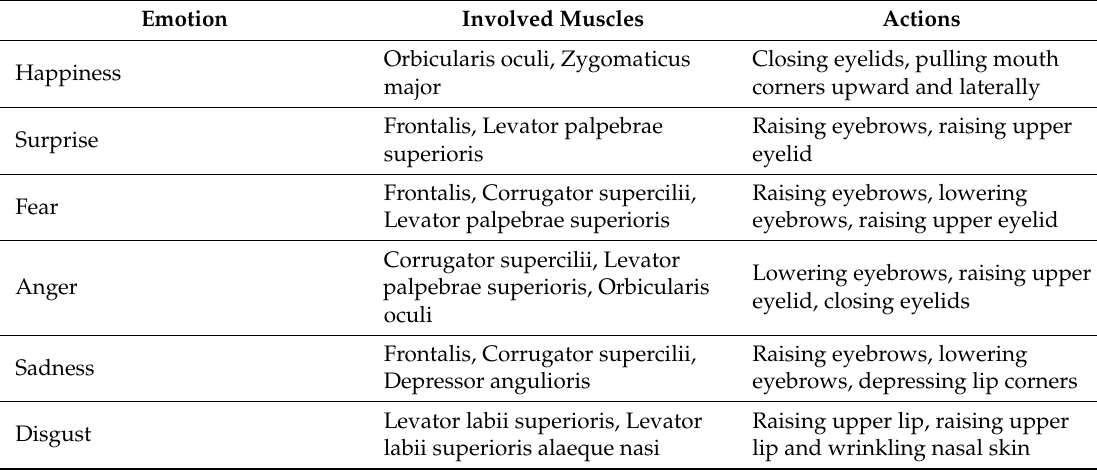
Table 9. Relations between emotions and facial expressions